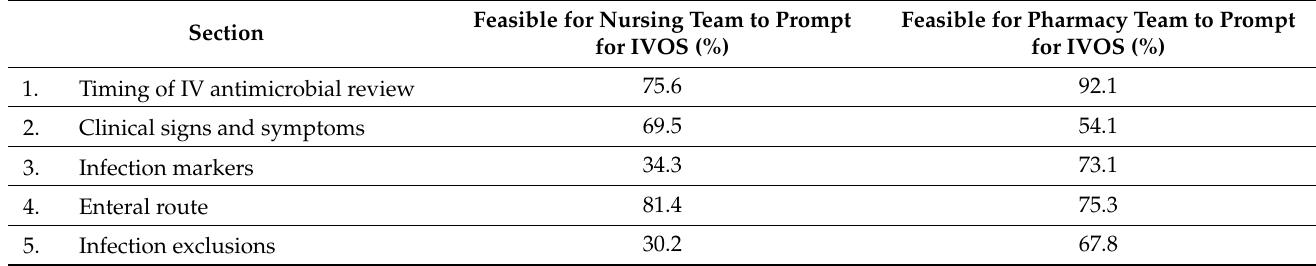
Table 3. Feasibility for nursing teams (scored ‘feasible’ or ‘very feasible’) to prompt for IVOS in relation to each of the 5 sections of IVOS